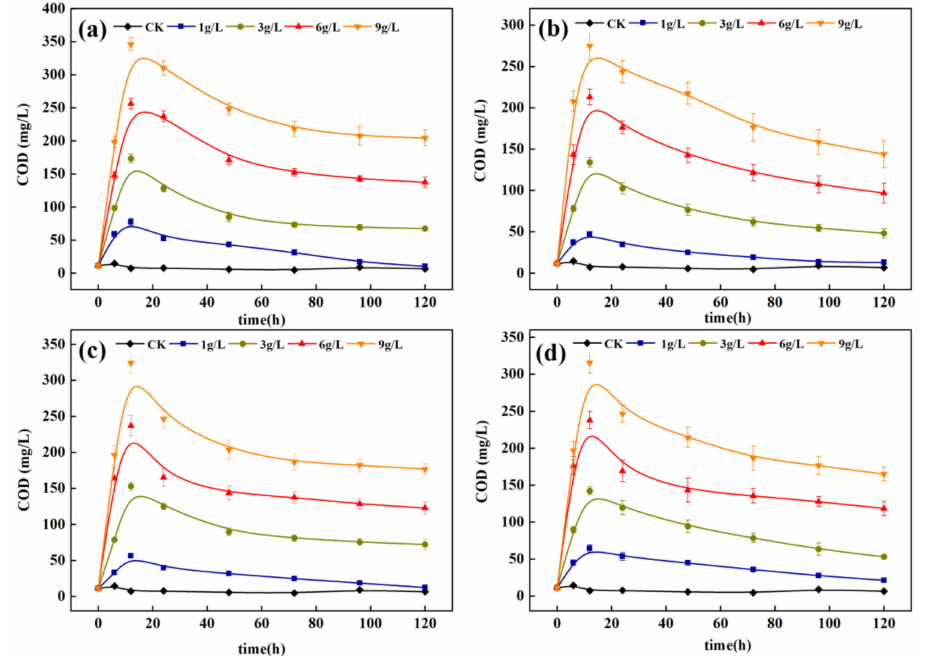
Figure 6. Changes of COD in water under different carbon source dosages. ( a ) PS; ( b ) SD; ( c ) PT; ( d )